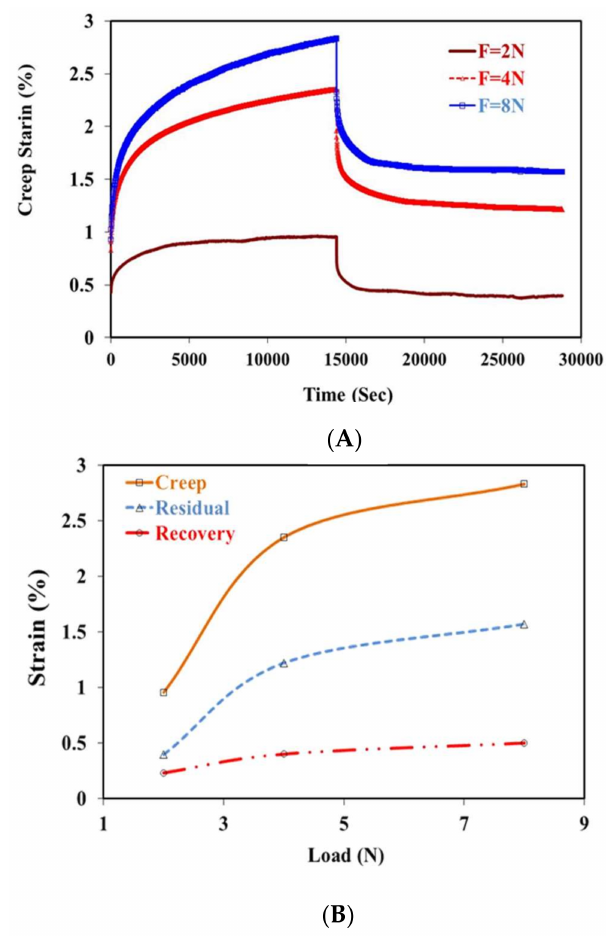
Figure 3. Effects of load on the creep behavior of porous